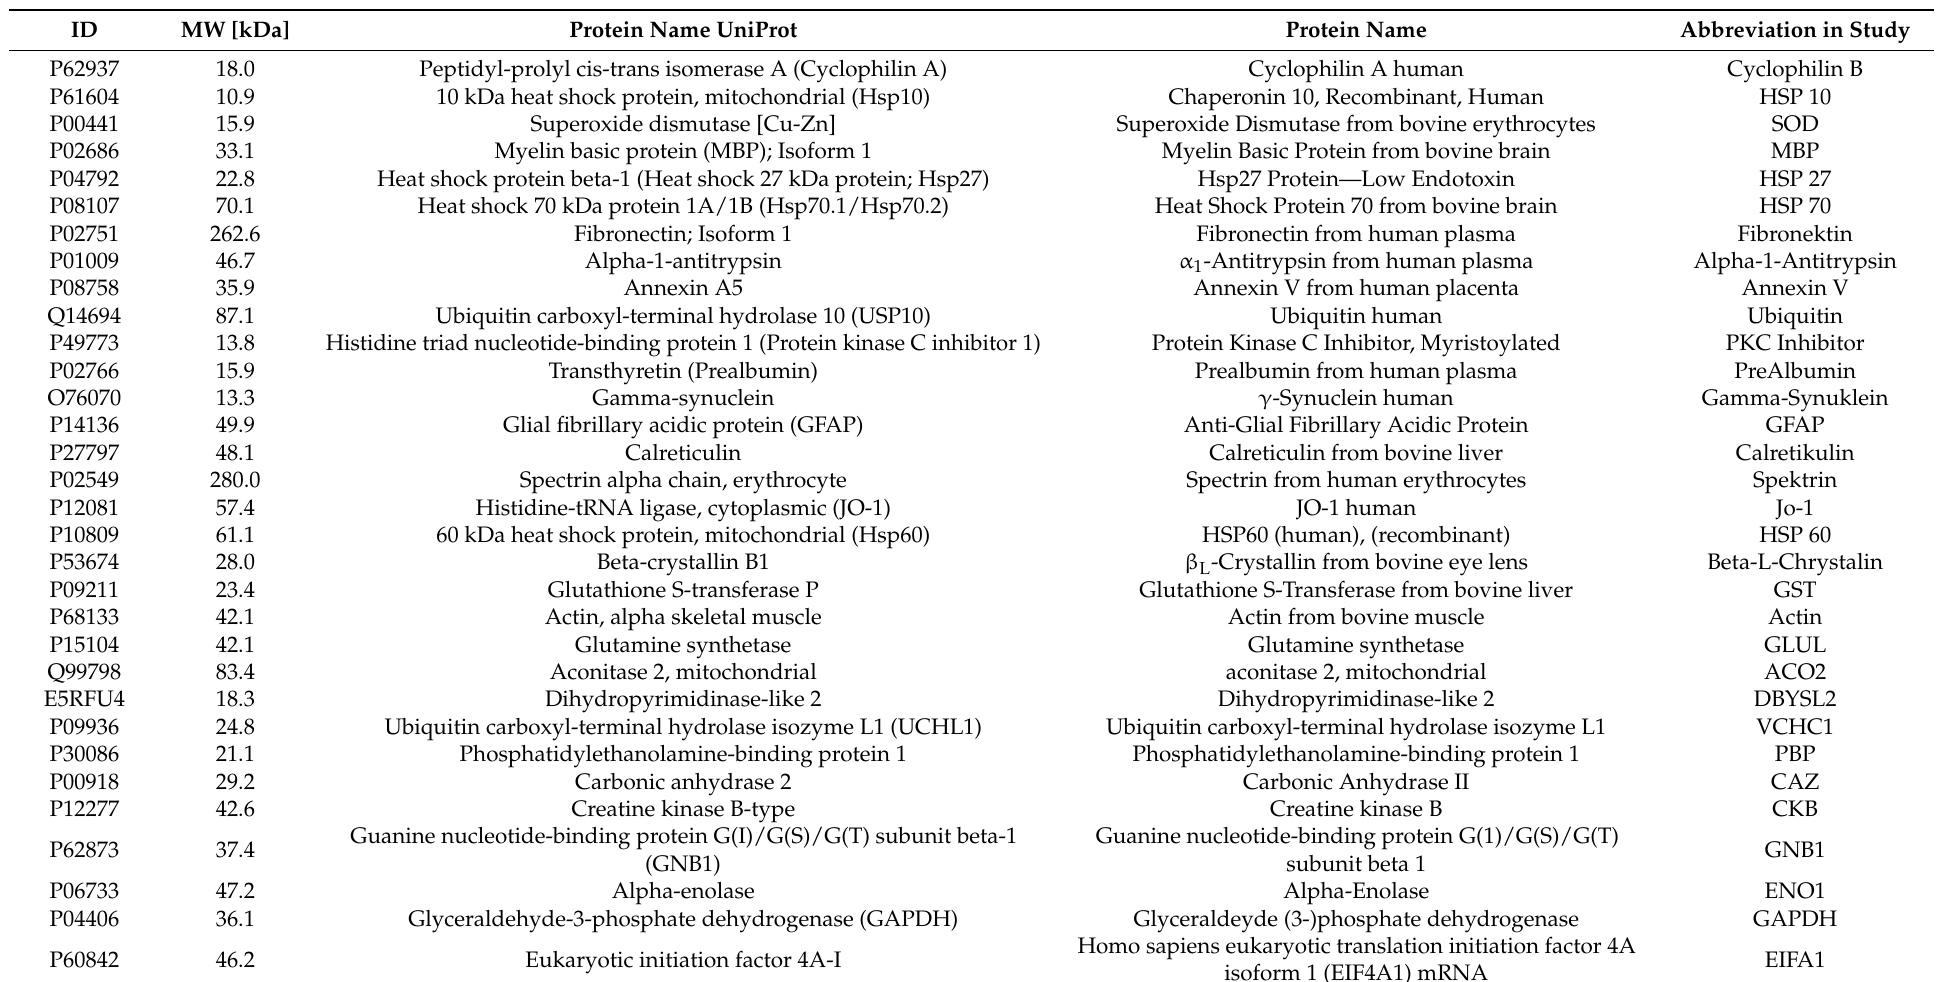
Table 2. List of antigens on customized